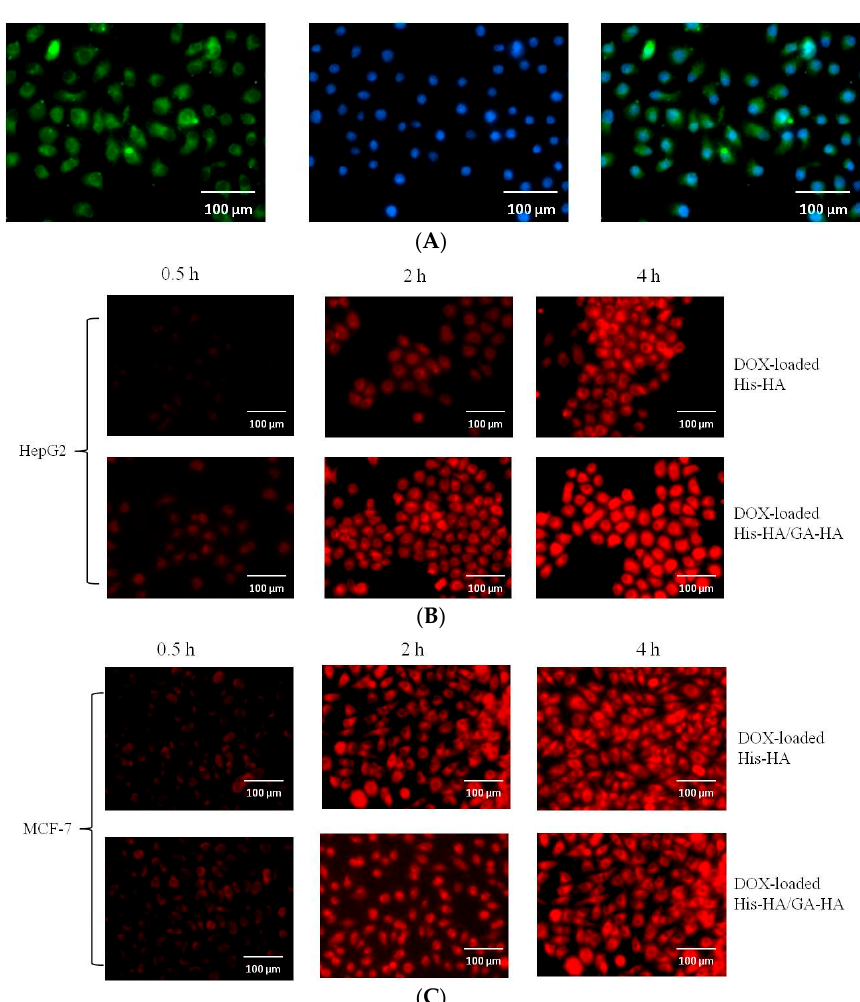
Figure 6. Fluorescence micrographs of HepG2 cells treated with FITC-labeled micelles ( A ); The cellular uptake of DOX-loaded micelles against HepG2 cells ( B ) and MCF-7 cells ( C ). FITC channel for FITC-labeled micelles (green), TRITC channel for DOX (red), and DAPI channel for nucleus (blue) were simultaneously presented.